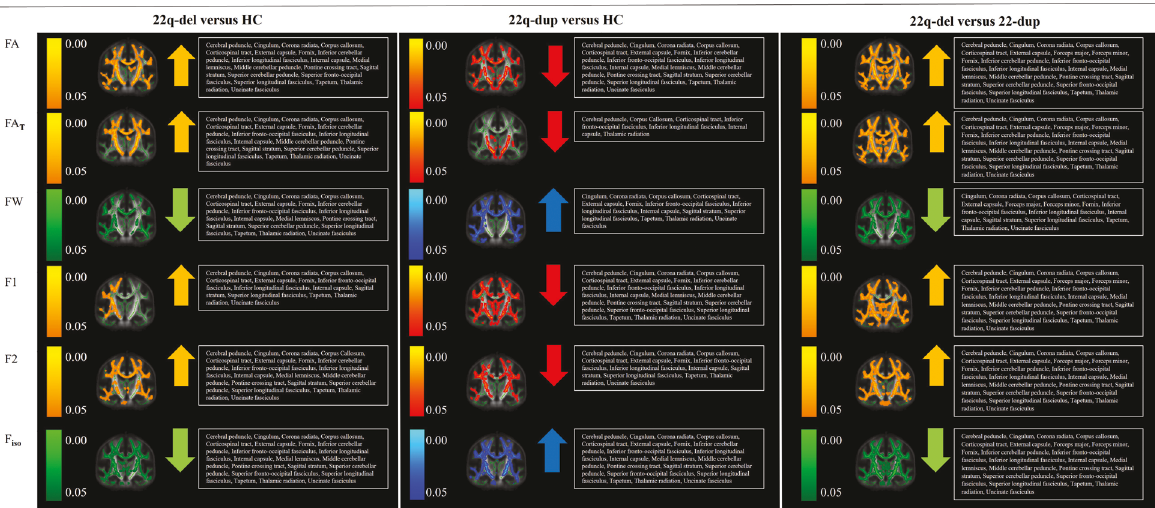
Fig. 1 Group comparisons between 22q11.2 deletion carriers (22q-del) and healthy controls (HC) (left), 22q11.2 duplication carriers (22q-dup) and HC (middle), and 22q-del and 22q-dup. Figure 1 displays the results from Tract-Based Spatial Statistics and Randomize [81, 82]. The white matter skeleton (thresholded at fractional anisotropy (FA) > 0.25) is shown in green on top of the average image of all registered FA images. Voxels that demonstrated signi fi cant group differences are thickened to increase visibility. The 22q-del group compared with the HC group (left) showed higher fractional anisotropy (FA; signi fi cant regions highlighted in orange), which remained higher in FA of the tissue (FA T ) values (in orange) after accounting for the effect of extracellular free-water (FW). 22q-del also showed lower FW values than HC (in green) and higher fractions of both the primary (F1) and secondary (F2) fi ber populations (in orange), and lower fractional volume of the isotropic compartment F iso (in green). In contrast, 22q-dup compared with HC (middle) presented with lower FA values (in red), as well as lower FA T (in red), higher FW values (in blue), lower fractions of the primary and secondary fi ber populations (F1, F2, in red) and higher F iso (in blue). A direct comparison between 22q-del and 22q-dup is provided on the right, showing widespread group differences. 22q-del displayed higher FA/FA T /F1/F2 (in orange) and lower FW/F iso (in green). Please note that TBSS provides a voxel-wise rather than tract-speci fi c output. The voxels that demonstrate group differences are widespread and located in most of the main fi ber tracts. For a tract-by-tract comparison of FA T and FW between groups, please see Supplementary Table